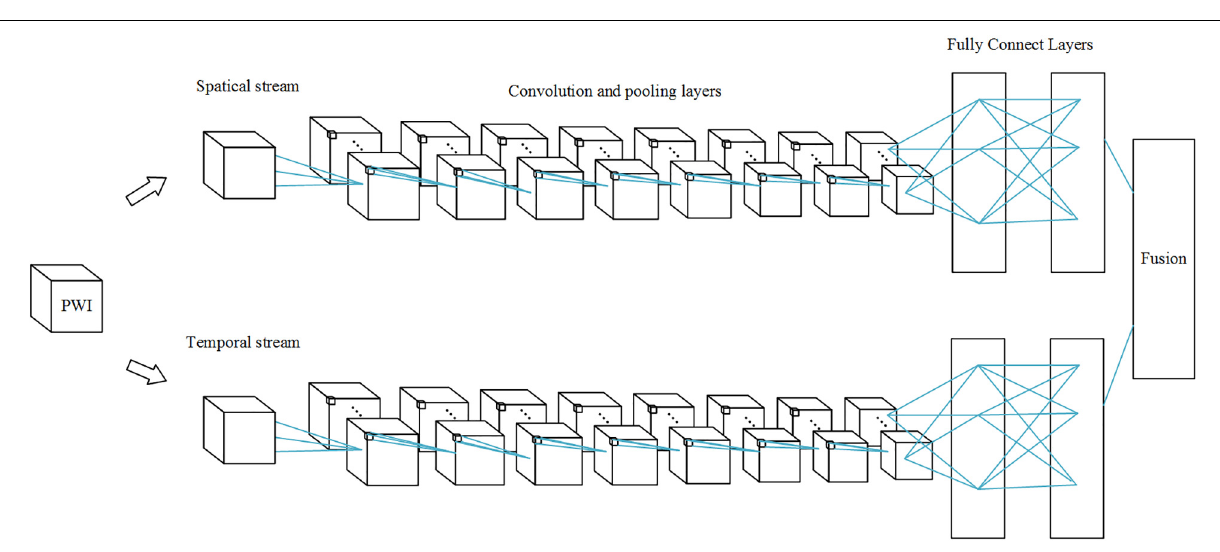
FIGURE 2 | Multi-stream 3D CNN network. Each stream is a 3D CNN network, and the streams are combined by a fusion layer using linear